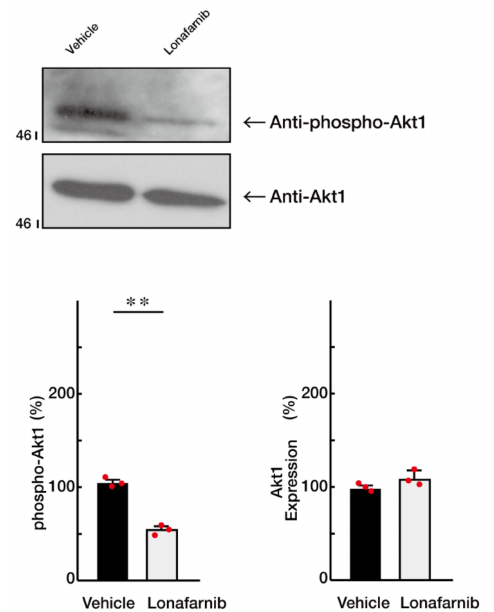
Figure 7. Ras inhibition decreases Akt1 phosphorylation. The lysates of vehicle or Lanafamib-treated FBD-102b cells were used for immunoblotting with an anti-phosphorylated (phospho) Akt1 or Akt1. These two different blots were performed from the same samples. Band intensities were also compared to be depicted in graphs (**, p < 0.01; n = 3